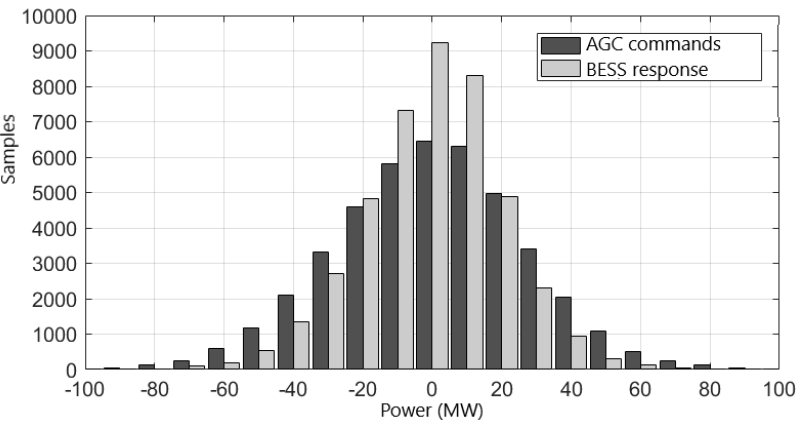
Figure 6. One hundred MW, 1 h BESS response and AGC instructions for 18 GW of wind power scenario.